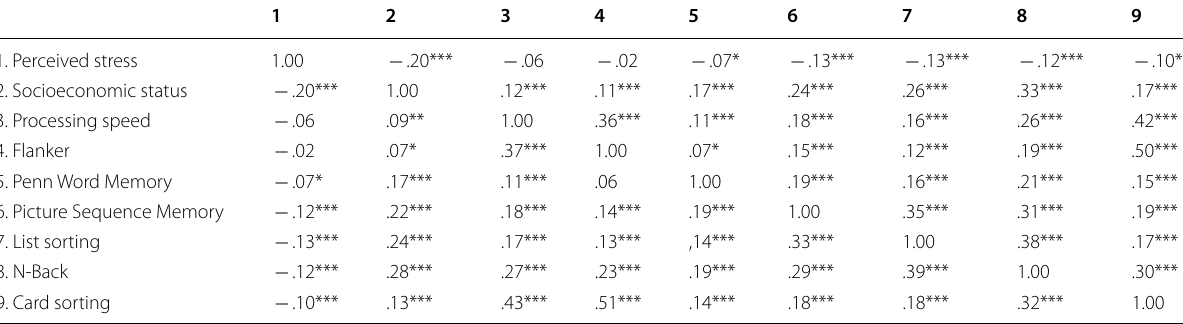
Table 2 Zero‑order and partial Pearson’s correlations across the whole